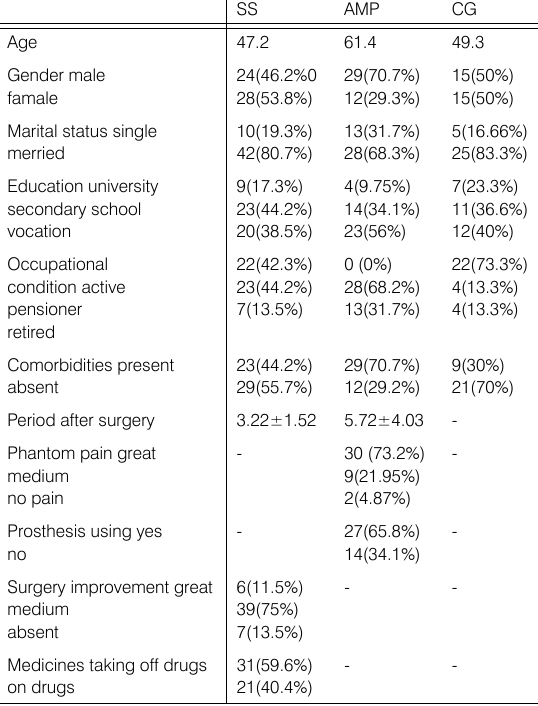
Table 1. Characteristics of examined groups (SS- patients after spine surgery, AMP-patients after limb amputation) and control group